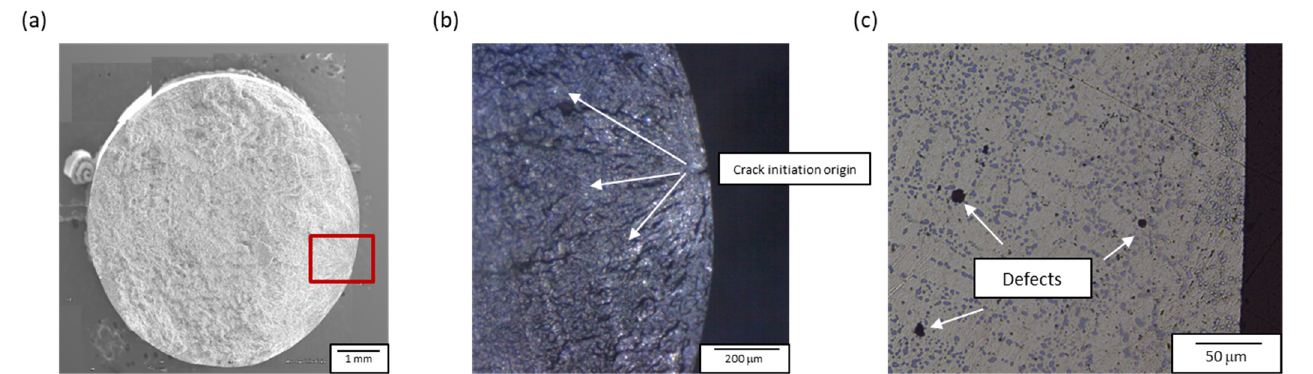
Figure 3. Schematics of inspection areas and assessment of the corresponding inclusion sizes.